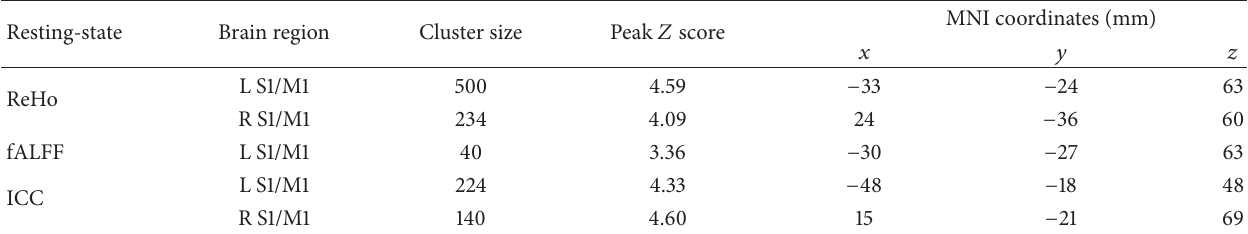
Table 3: Comparisons of ReHo, fALFF, and ICC values in resting-state between BP patients and healthy controls using small volume FWE correction. Resting-state Brain region Cluster